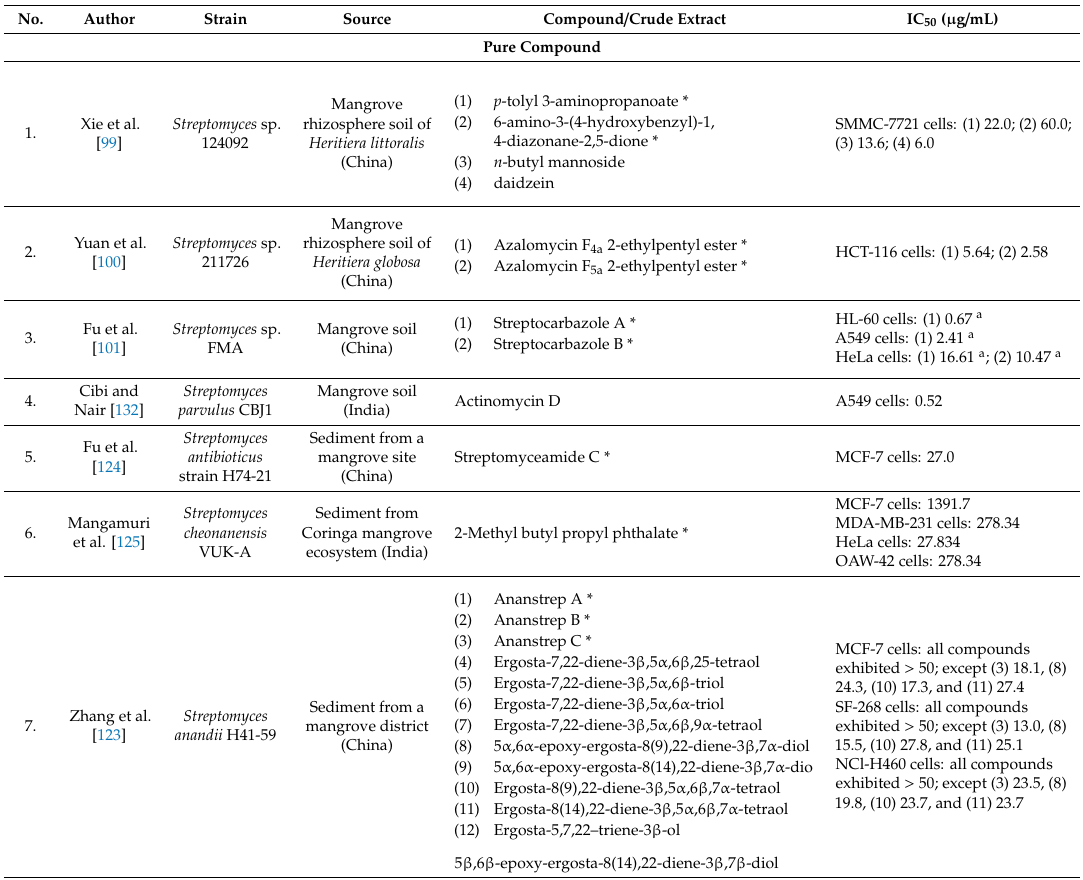
Table 1. Summary of studies pertaining to the anticancer / cytotoxic activity of mangrove-derived Streptomyces during the period